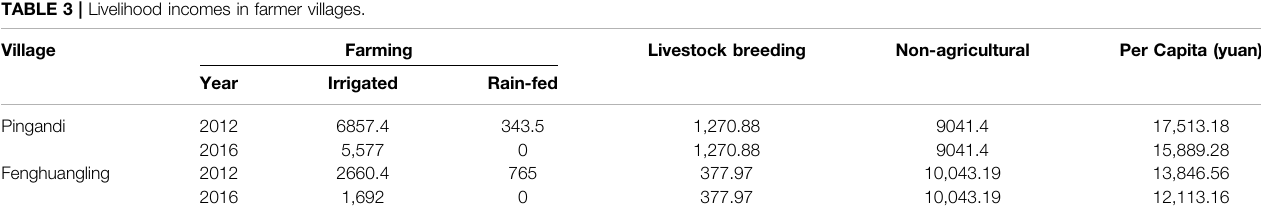
TABLE 3 | Livelihood incomes in farmer villages.